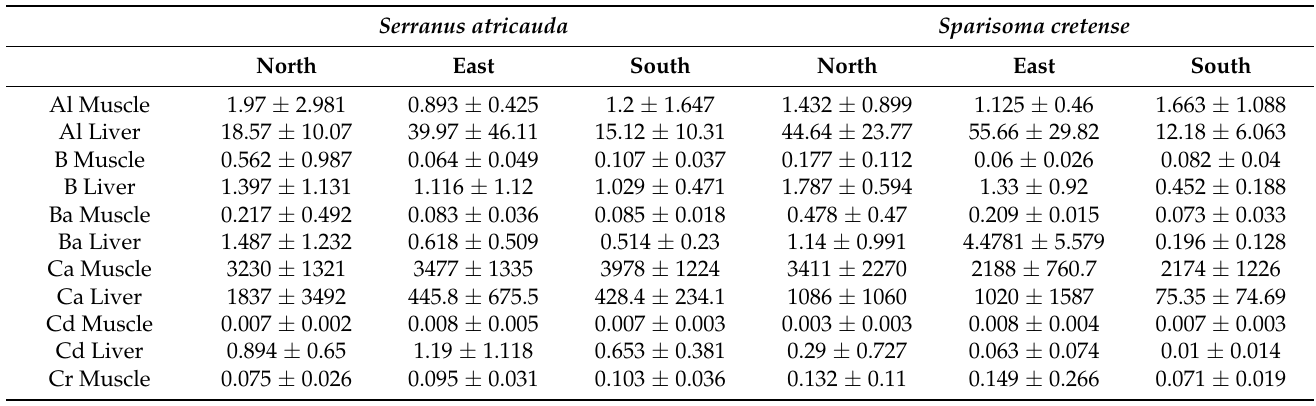
Table 2. Means and standard deviations (in mg/kg) of Serranus atricauda and Sparisoma cretense according to study area.